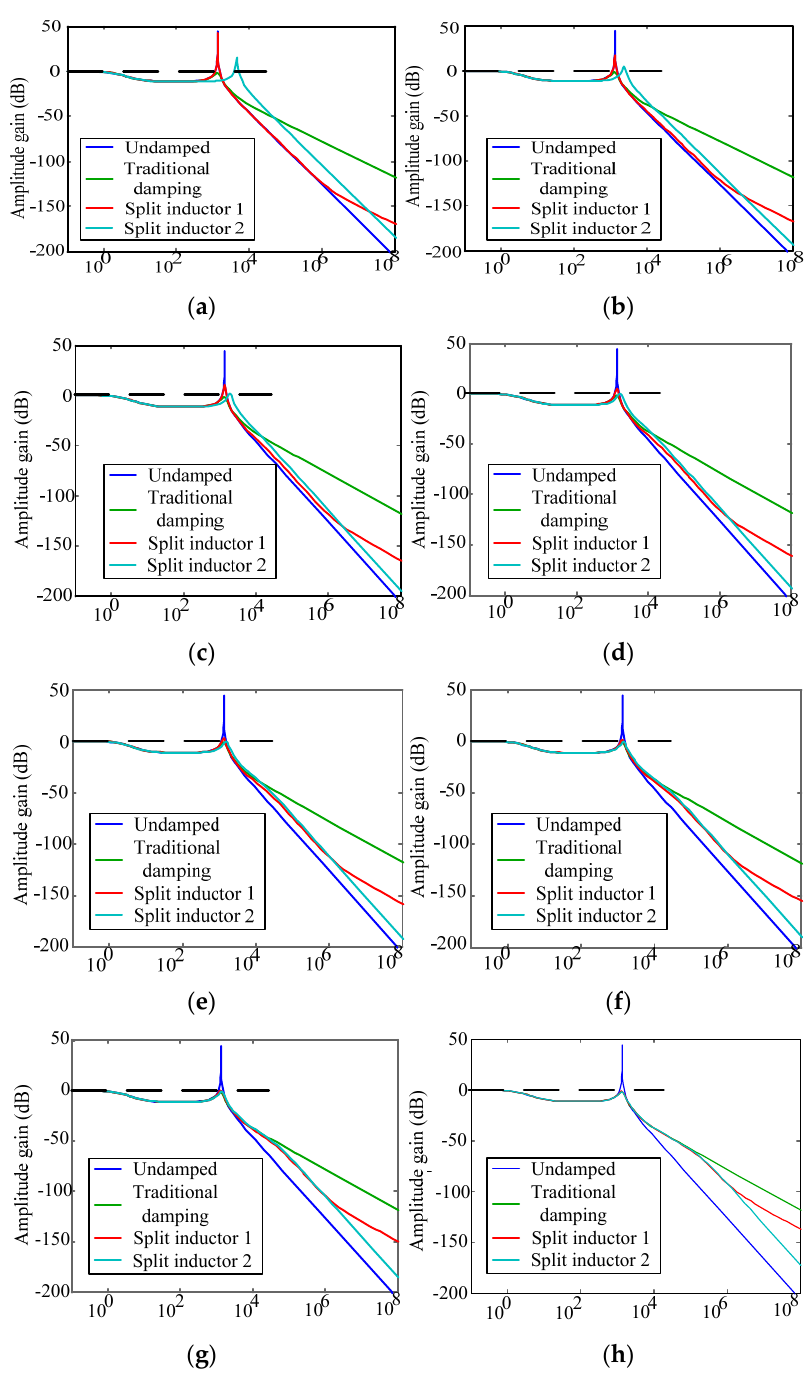
Figure 6. Comparison of system gains at different split inductor ratios. ( a ) n = 0.1, f/Hz; ( b ) n = 0.5, f/Hz; ( c ) n = 1, f/Hz; ( d ) n = 2, f/Hz; ( e ) n = 3, f/Hz; ( f ) n = 5, f/Hz; ( g ) n = 10, f/Hz; ( h ) n = 50, f/Hz.